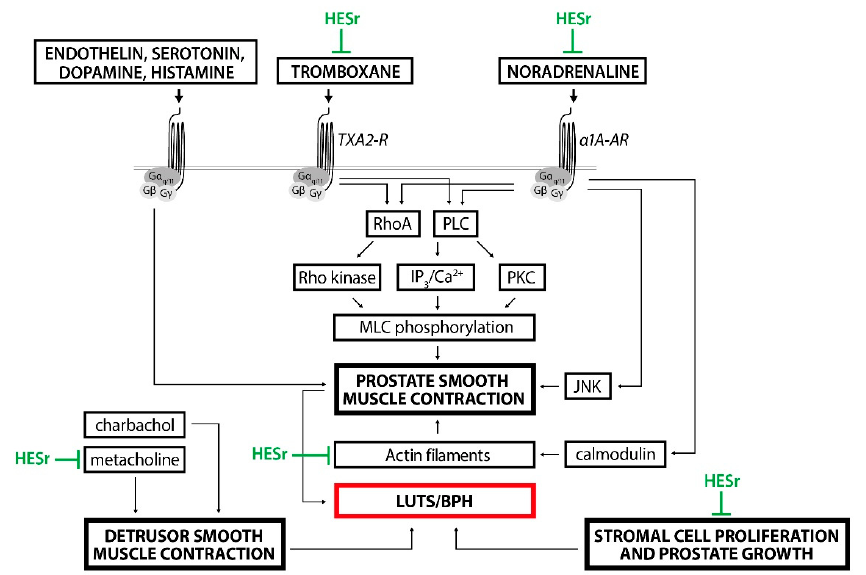
Figure 5. Mechanisms of HESr action in the management of LUTS/BPH. HESr inhibitory effects (green) on different targets and shared intracellular mediators contribute to the LUTS/BPH symp- tom relief on multiple levels. Modified from [47,48]. TXA2-R—tromboxane A2 receptor; α 1A-AR— α 1A-adrenoreceptor.